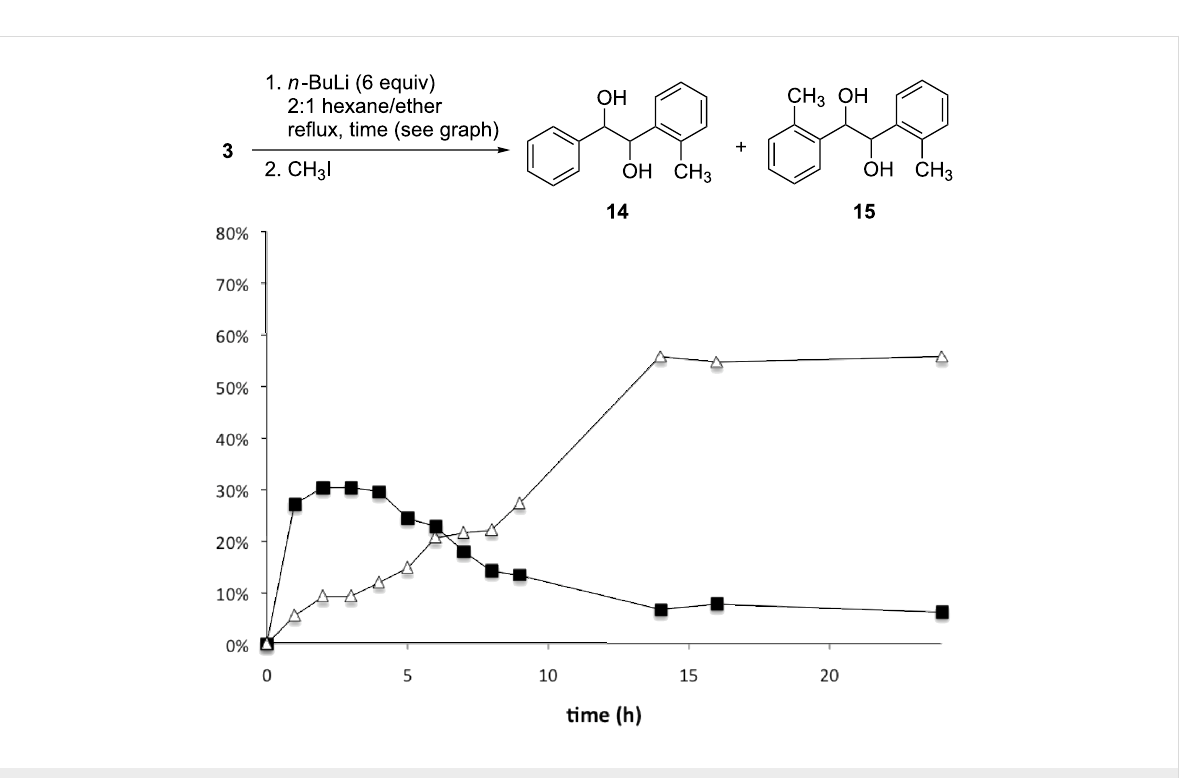
Figure 3: Percentage of methylhydrobenzoin ( 14 ) ( ■ ), and dimethylhydrobenzoin ( 15 ) ( Δ ) as determined by 1 H NMR spectroscopy. The remainder of the material is recovered ( R , R )-hydrobenzoin ( 3